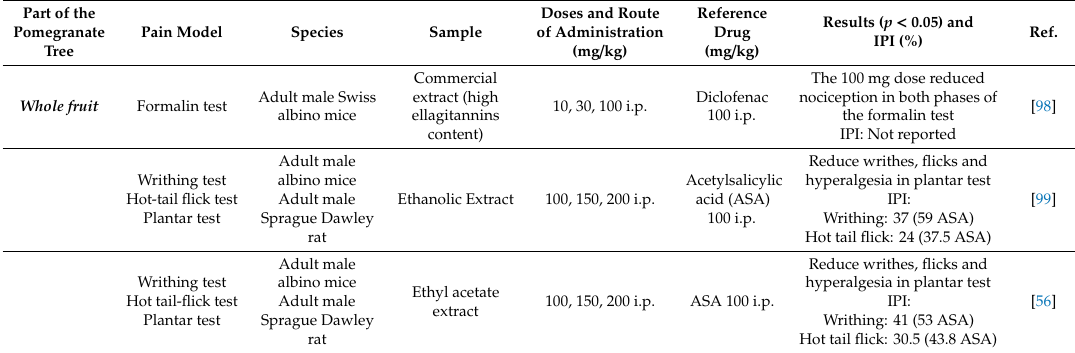
Table 2. E ff ect of di ff erent parts of pomegranate on nociception and analgesia in many pain